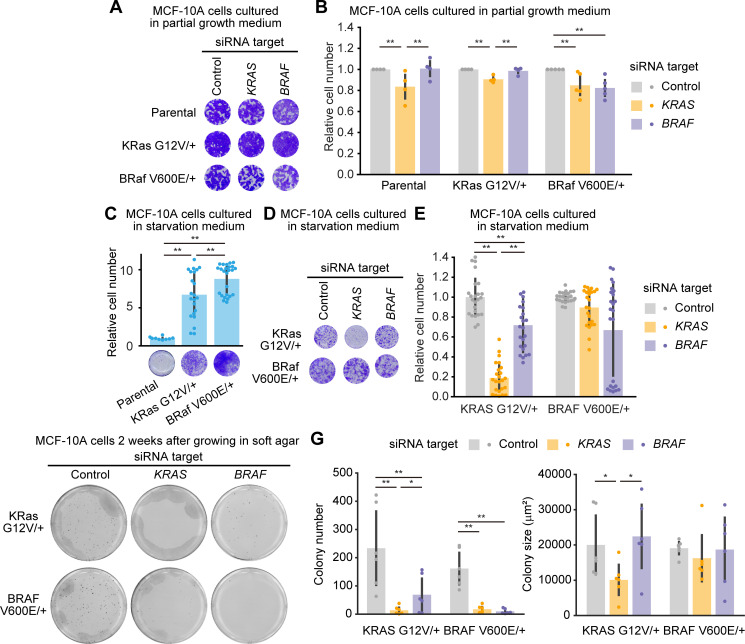
Evaluation of oncogenic KRAS or BRAF addiction in MCF-10A cells harboring a single allele mutation of KRAS G12V or BRAF V600E.(A and B) Cell growth assays following siRNA-mediated negative control, KRAS, or BRAF ablation in the parental MCF-10A, KRAS G12V/+, and BRAF V600E/+ cell lines grown in the partial growth medium. Three days after transfection with siRNA, relative cell densities were determined by crystal violet staining. (A) Representative 96-well plates are shown. (B) The mean relative cell number is shown with the SD (Parental, n = 4; KRAS G12V/+, n = 4; BRAF V600E/+, n = 5). Dots indicate actual data points. (C) Cell growth assays in the parental MCF-10A, KRAS G12V/+, and BRAF V600E/+ cell lines grown in starvation medium for four days with the indicated siRNA. Relative cell densities were determined by crystal violet staining. (Lower) Representative 96-well plates are shown. (Upper) Mean relative cell numbers are shown with the SD (Parental, n = 9; KRAS G12V/+, n = 22; BRAF V600E/+, n = 25). Dots indicate actual data points. (D and E) Cell growth assays following siRNA-mediated negative control, KRAS, or BRAF ablation in the KRAS G12V/+ and BRAF V600E/+ cell lines grown in starvation medium. Four days after transfection with siRNA, relative cell densities were determined by crystal violet staining. (D) Representative 96-well plates are shown. (E) The mean relative cell number is shown with the SD (KRAS G12V/+, n = 25; BRAF V600E/+, n = 25). Dots indicate actual data points. (F) Representative images of MTT-stained colonies of the indicated cells seeded in soft agar for 2 weeks. (G) The mean number of colonies (left) and the mean colony size (μm2) (lower) are shown with the SD. Dots indicate actual data points. The numbers of experiments are as follows: KRAS G12V/+, n = 6; BRAF V600E/+, n = 6. * p < 0.05, ** p < 0.01.